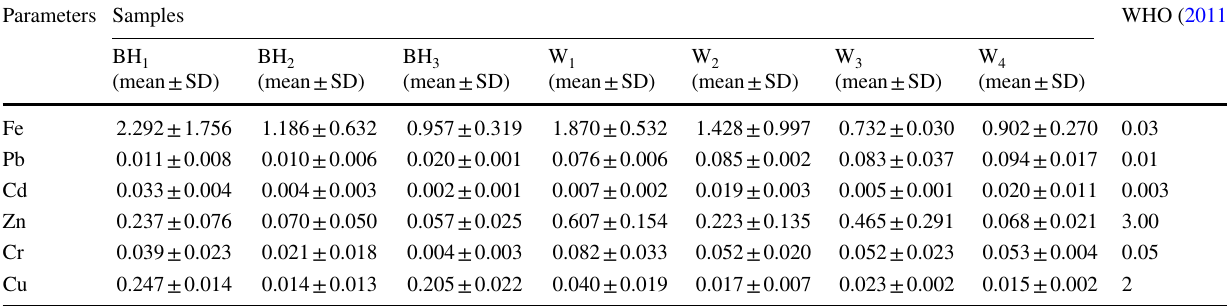
Table 6 Heavy metal concentrations in the borehole and well water samples around the Oti landfill site